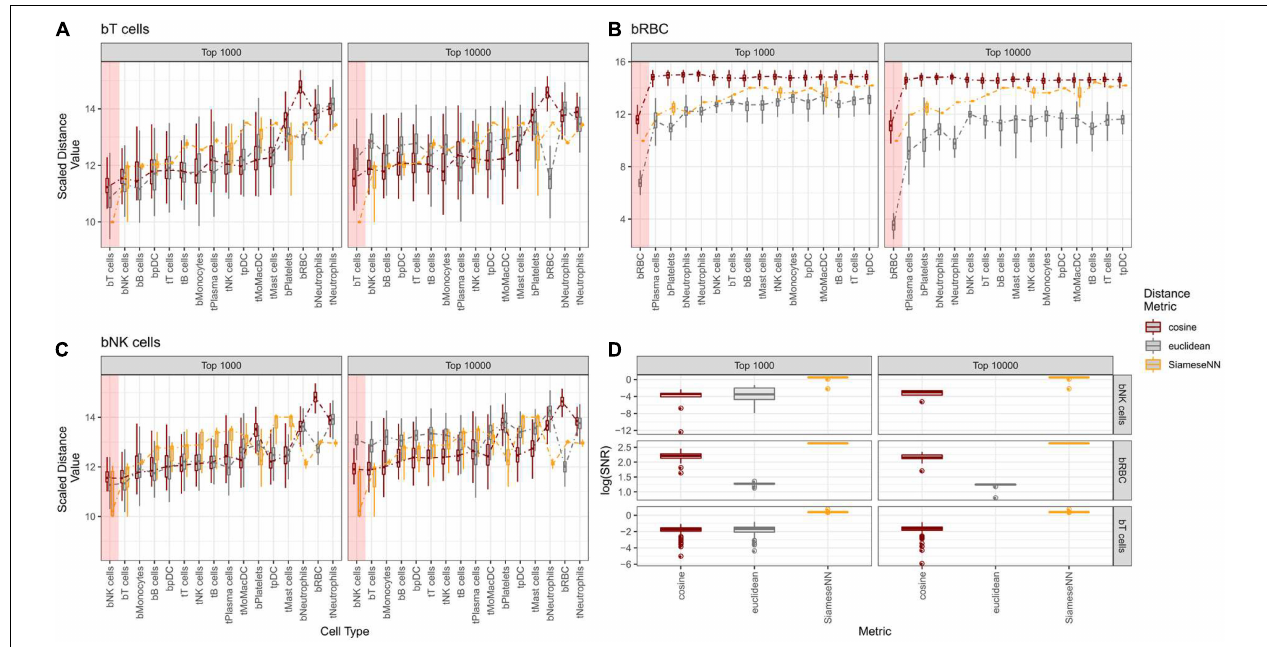
FIGURE 3 | Contrasting Cosine and Euclidean against Siamese Neural Network (SNN) distance for T-cells, RBC, and NK cells. (A–C) Boxplots showing distribution of pairwise distance scores between each annotated cell type from the test set against annotated cell type from the training set. For cosine and euclidean distances, the top 1,000 and 10,000 most variable genes were used to calculate pairwise distance scores. For SNN, all genes were used as input to neural network. The x-axis is ordered from left to right by the SNN distance values in ascending order. Colored red box indicates the reference cell type with the average closest distance. (D) Boxplot showing the distibution of signal-to-noise values for each predicted cell